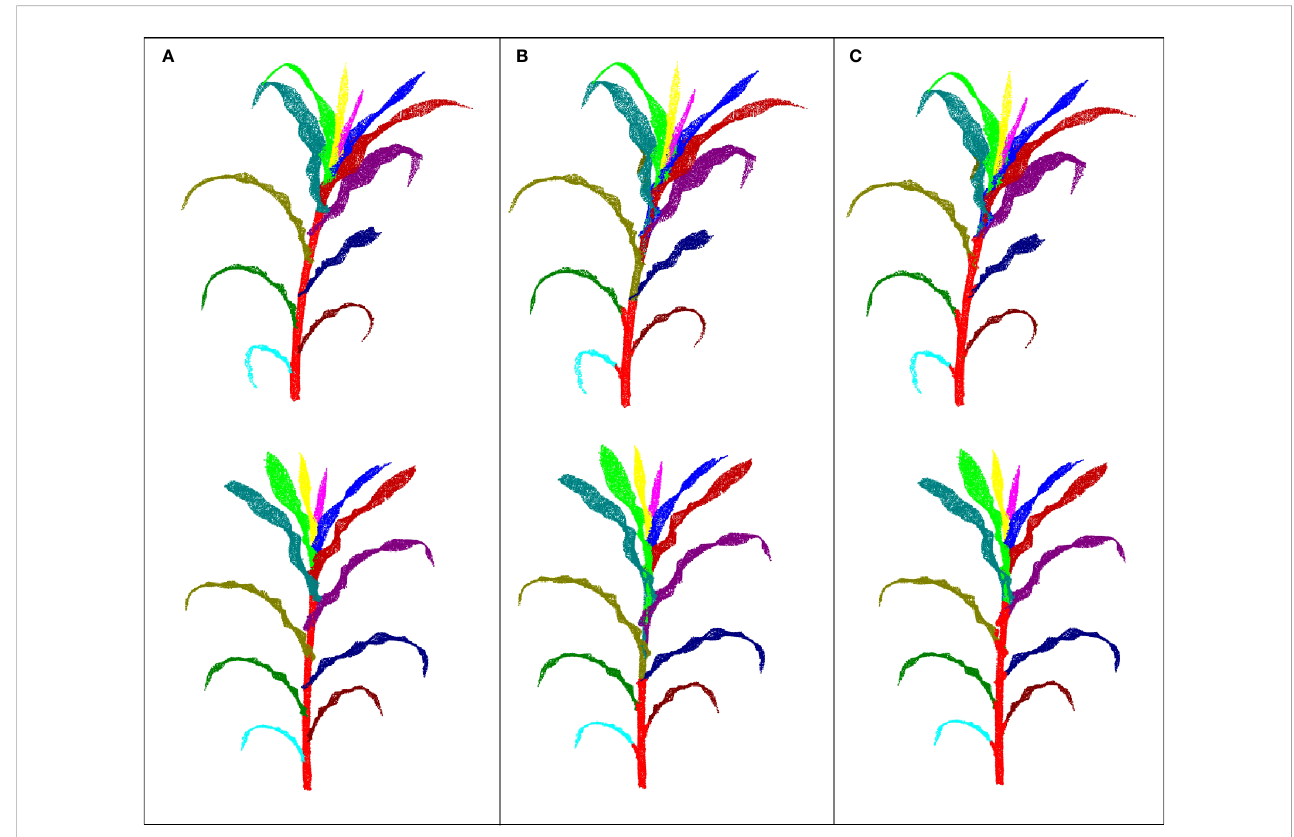
FIGURE 9 Segmentation results of stems with different m values. (A) Ground truth; (B) m =0.3; (C) m